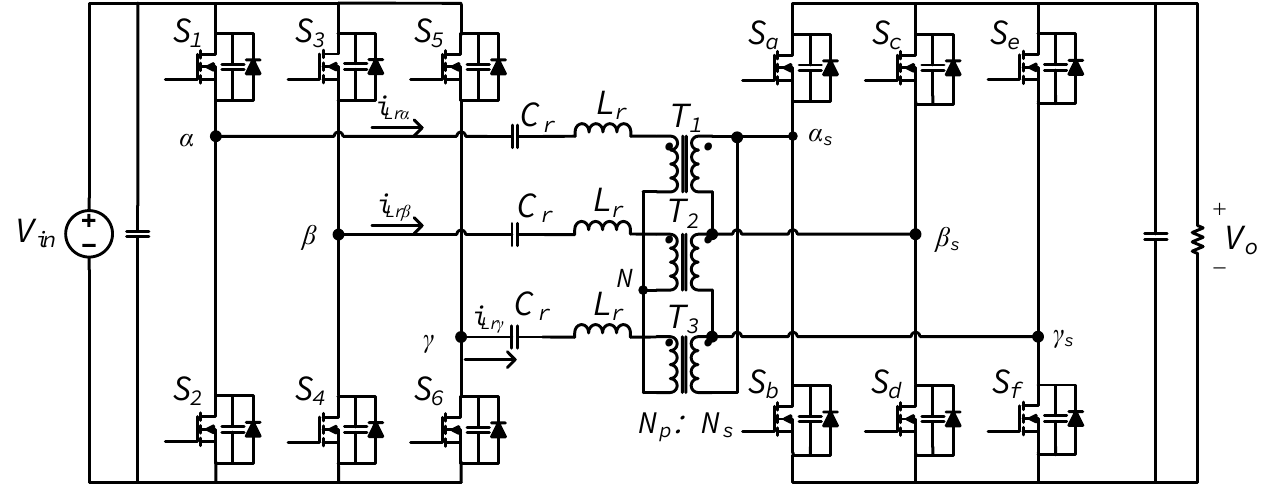
Figure 1. Three-phase series-resonant converters (SRC) schematic.